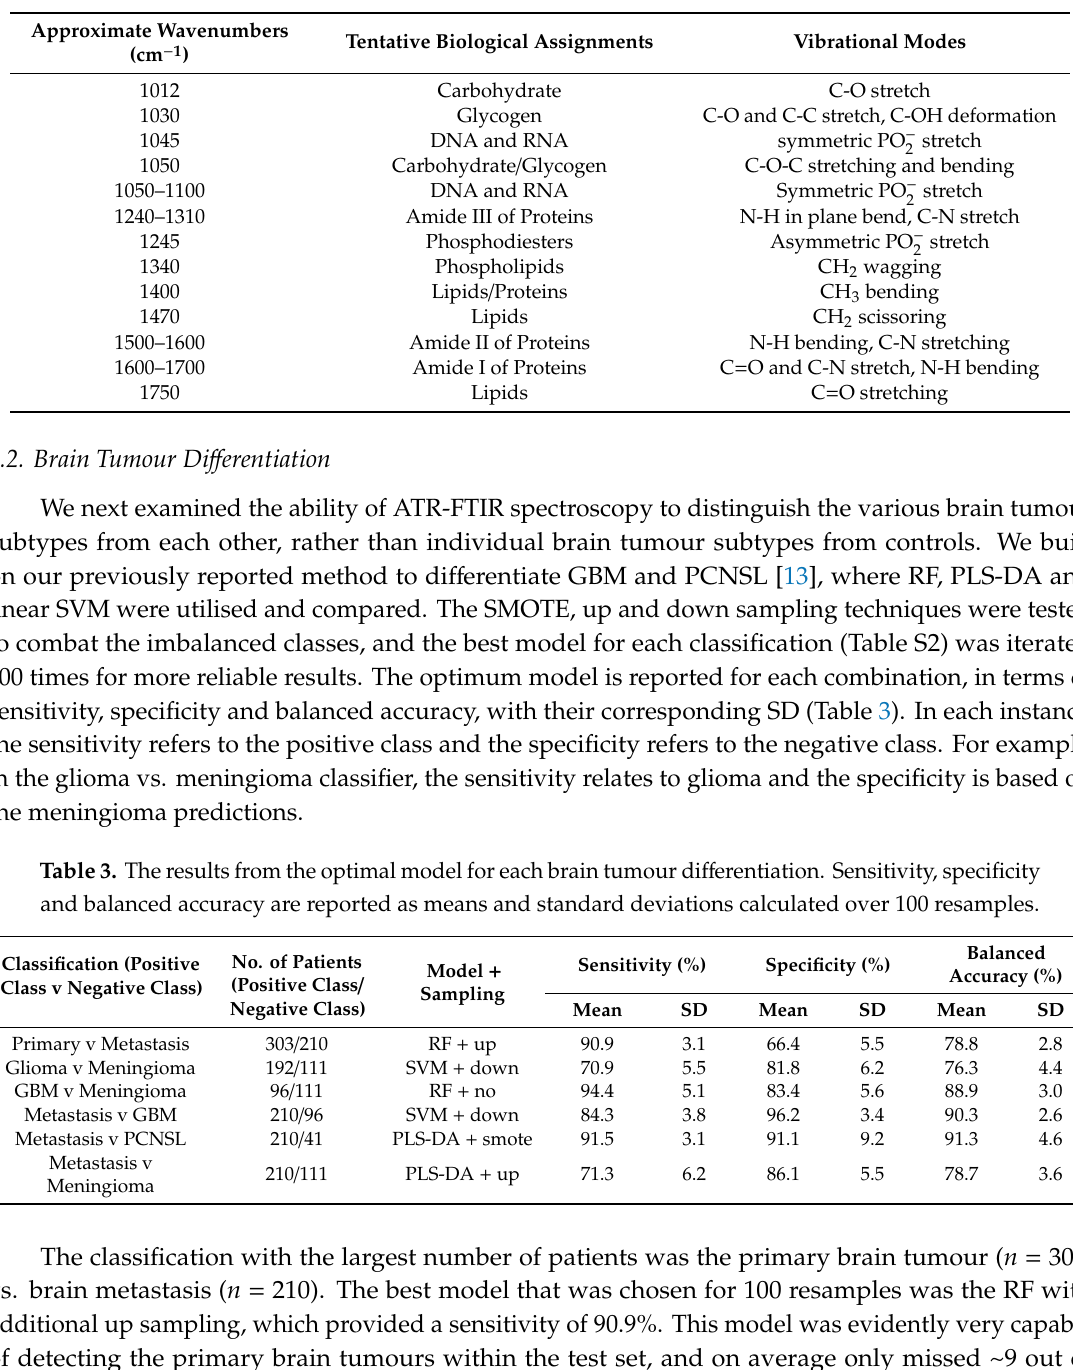
Table 2. The main wavenumbers involved in each of the four brain tumour subtypes vs. control classifications, with tentative biological assignments.